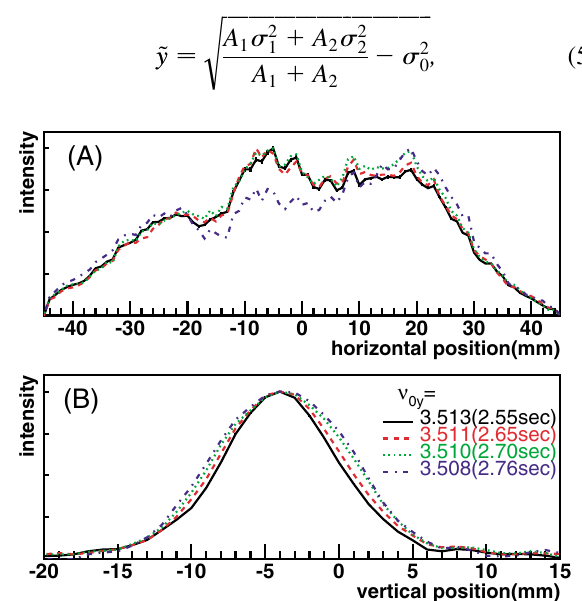
FIG. 5. (Color) Projections of the profiles on horizontal (a) and vertical (b) plane. The solid (black), dashed (red), dotted (green) and dash-dotted (blue) lines show the profile at (cid:2) 3 : 513 , 3.511, 3.510 and 3.508, respectively. Those profiles are normalized with their peak values.